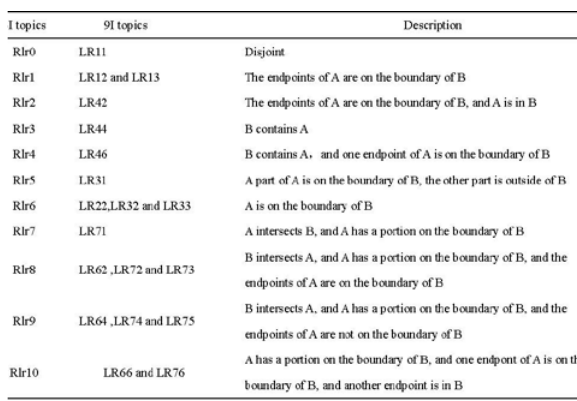
Table 2. Line-polygon Topological Relation of 4I and